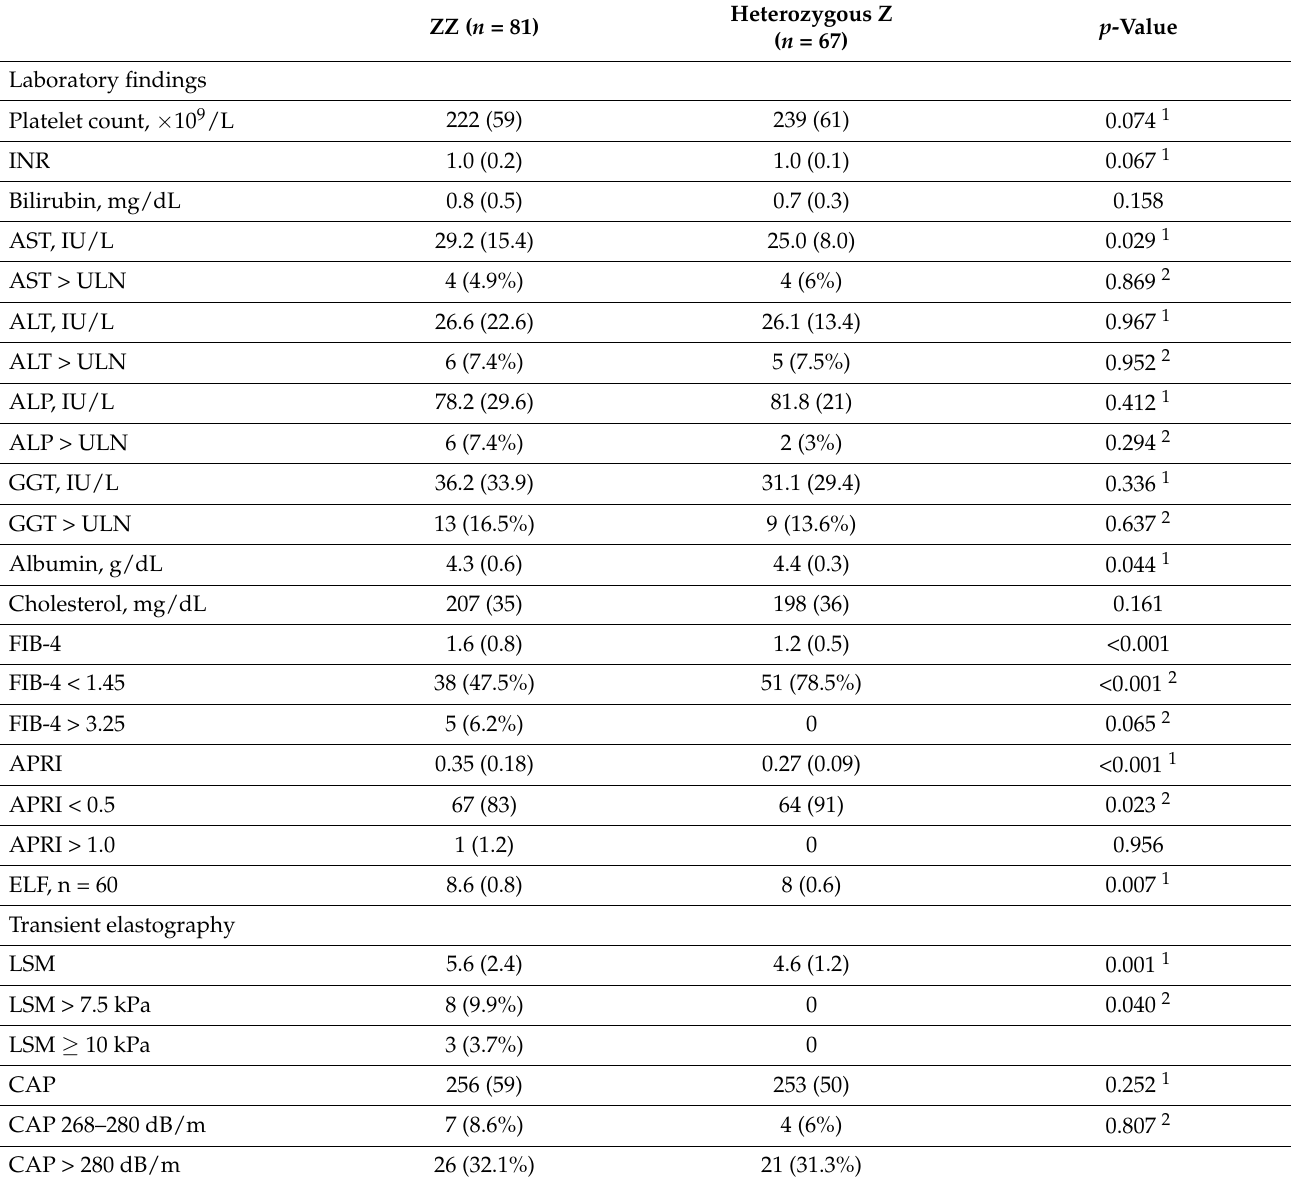
Table 2. Results of blood analysis and transient elastography in patients with different AAT genotypes. Heterozygous ZZ ( n = 81)